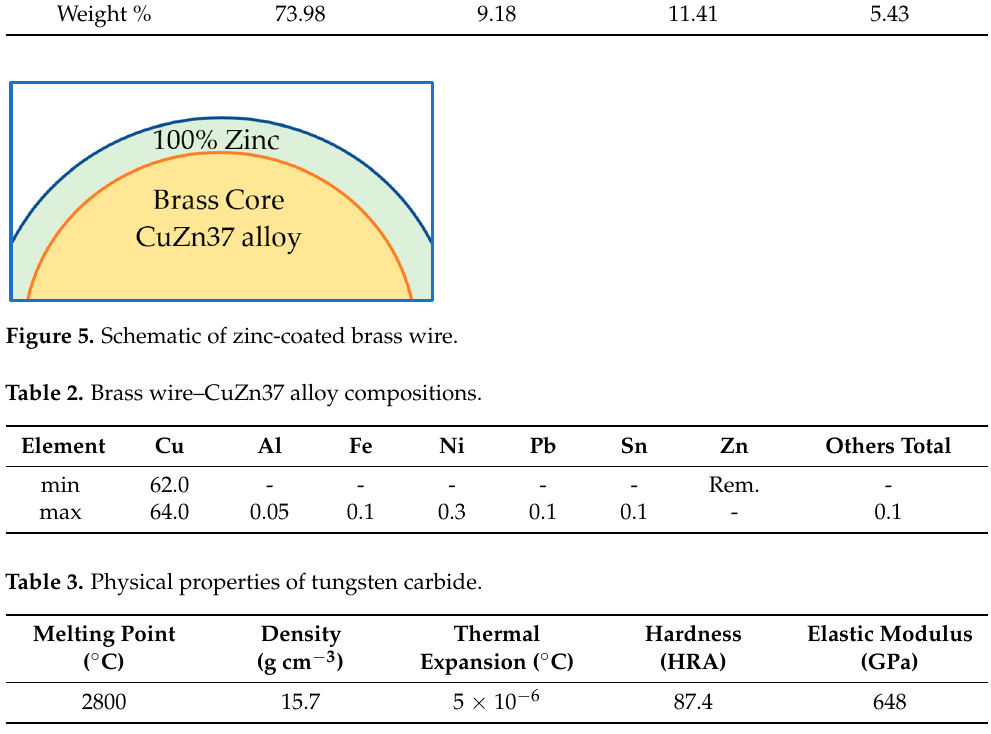
Table 4 . Properties of zinc - coated brass wire .